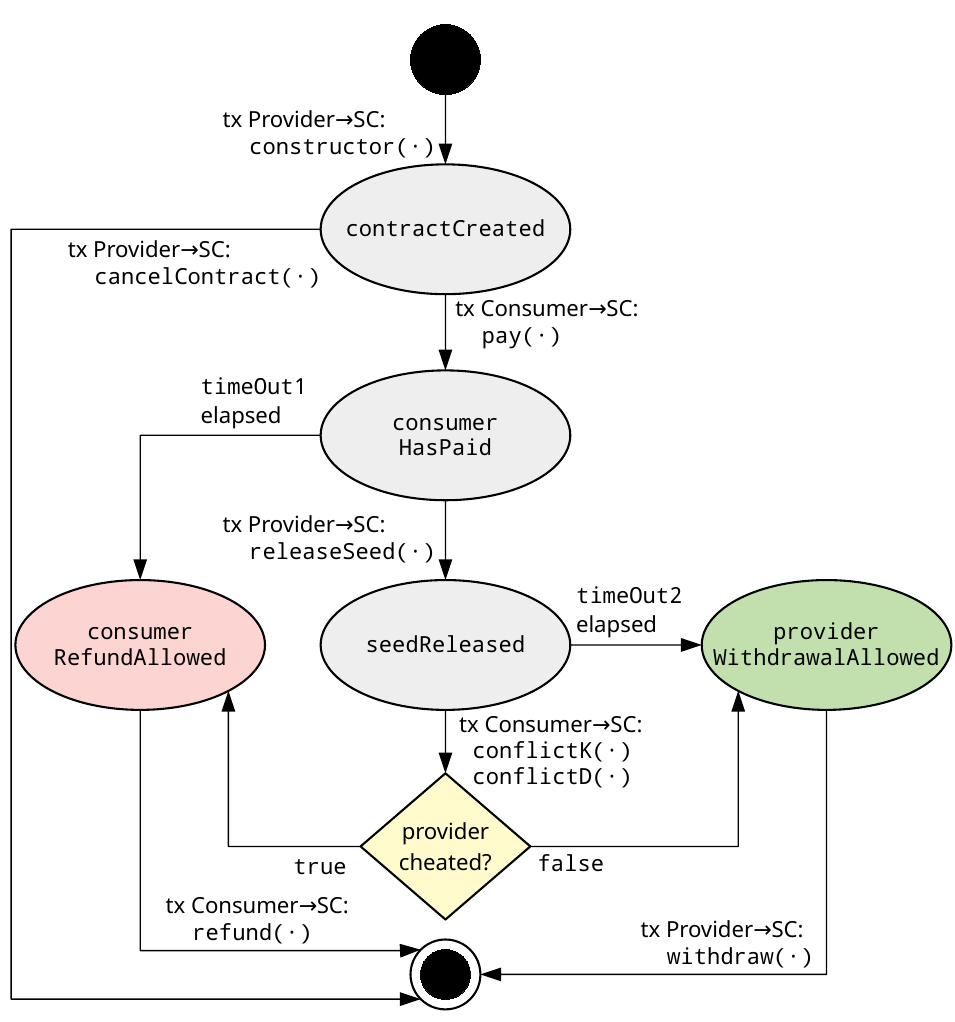
Figure 9. State diagram of the smart